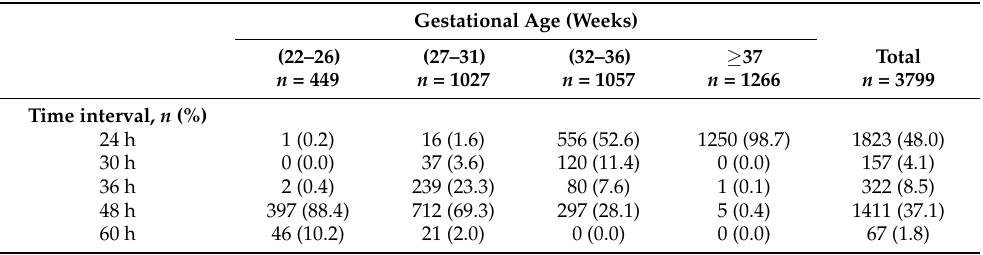
Table 2. Time interval between unit doses at first amikacin prescription according to gestational age during the first week of